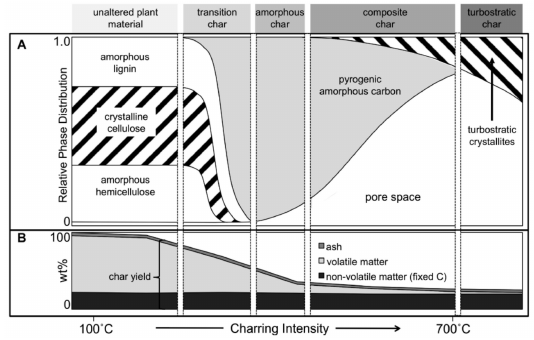
Figure 4. The evolution of biochar as the pyrolysis temperature rises: ( A ) physicochemical characteristics of organic phases; ( B ) char composition. Reprinted with permission from Reference [52]. Copyright (2010) American Chemical